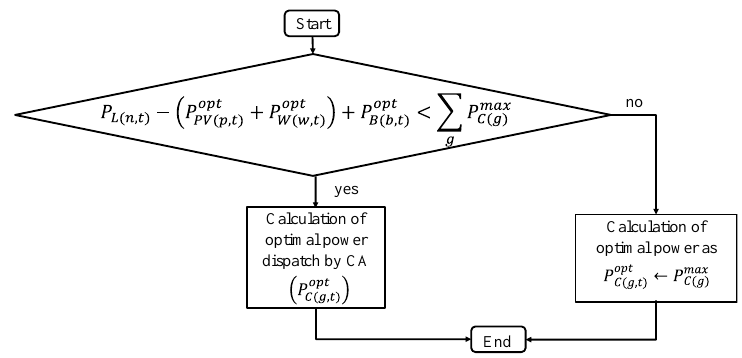
Figure 7. Flowchart of BESS power dispatch.